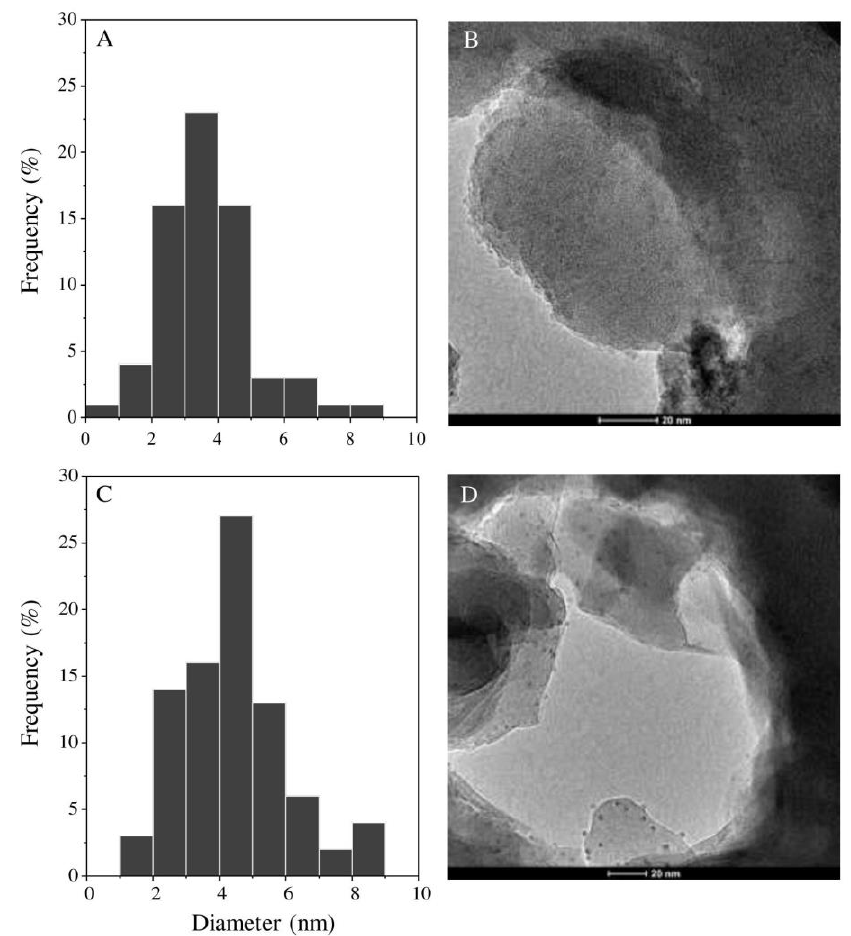
Figure 5. TEM micrographs of synthesized hybrid (AgCl, Ag)NPs / diatomite composites with silver concentrations of 4.65% ( A , B ) and 7.21% ( C , D ).